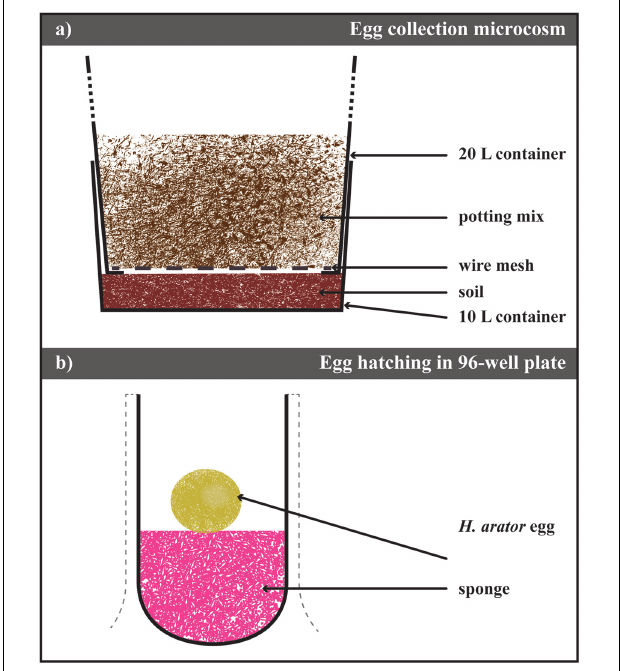
FIGURE 1 | Laboratory maintenance of Heteronychus arator population. (a) Schematic drawing of the microsm used to collect eggs. It consisted of two containers inserted one into the other. The bottom of the top container was replace with a metal mesh allowing the insect move to the bottom one containing soil from the field site of the insect collection. Eggs were recovered from this layer of soil after sieving. (b) Schematic drawing of the methodology used to hatch eggs. Eggs were laid on a moist piece of sponge and stored until hatching. Details of both protocols in the